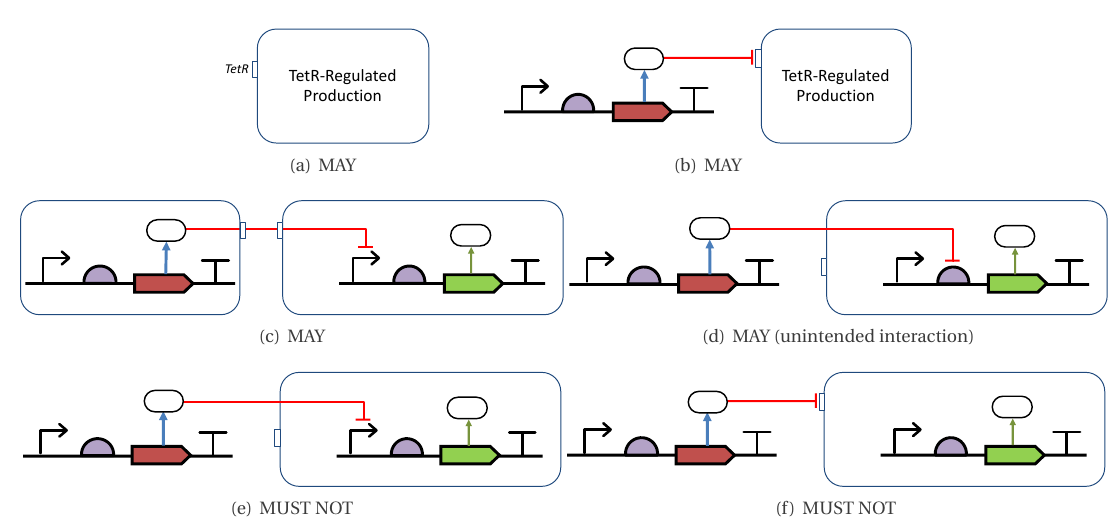
Figure 25: Examples of recommended and problematic subsystem interfaces: (a) interface on a black-box subsystem, (b) interaction with a black-box interface, (c) boundary-crossing interaction passing through an interface, (d) unintended interaction with a non-interface element, but (e) interactions with features in the interface must pass through the interface rectangle and (f) when the subsystem is shown, interactions MUST NOT terminate at the interface